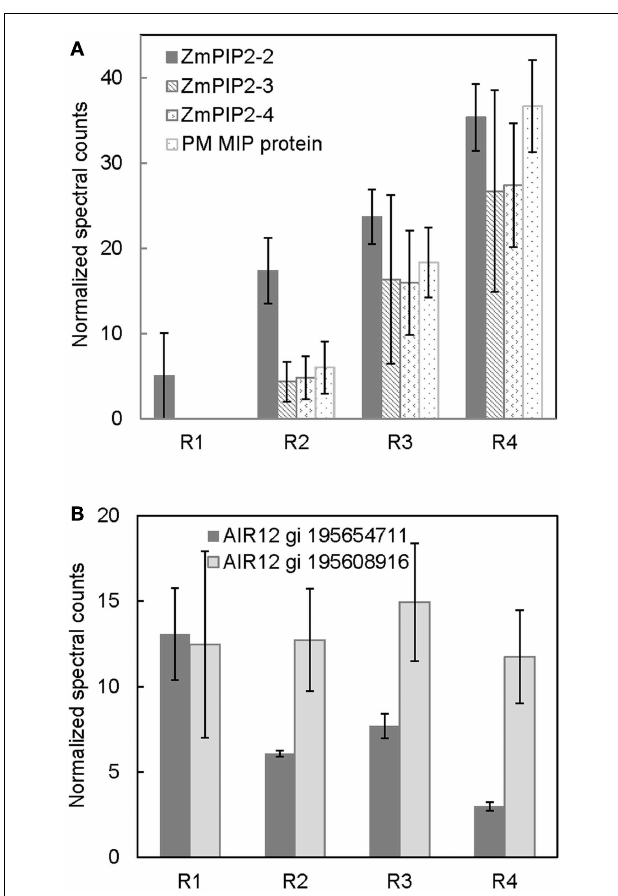
FIGURE 3 | Spatial distribution of (A) aquaporin protein abundances, and (B) ZmAIR12 protein abundances in R1–4 of the maize primary root harvested 48h after transplanting to well-watered conditions. Data are means ± SE of normalized spectral counts from three replicate